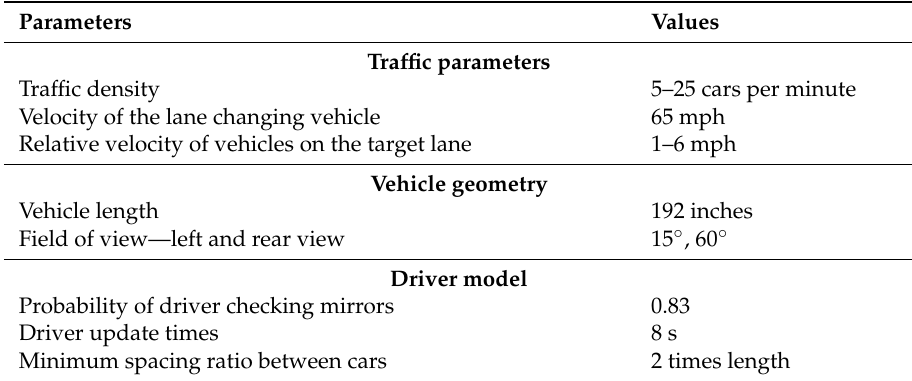
Table 1. Default input parameters of the